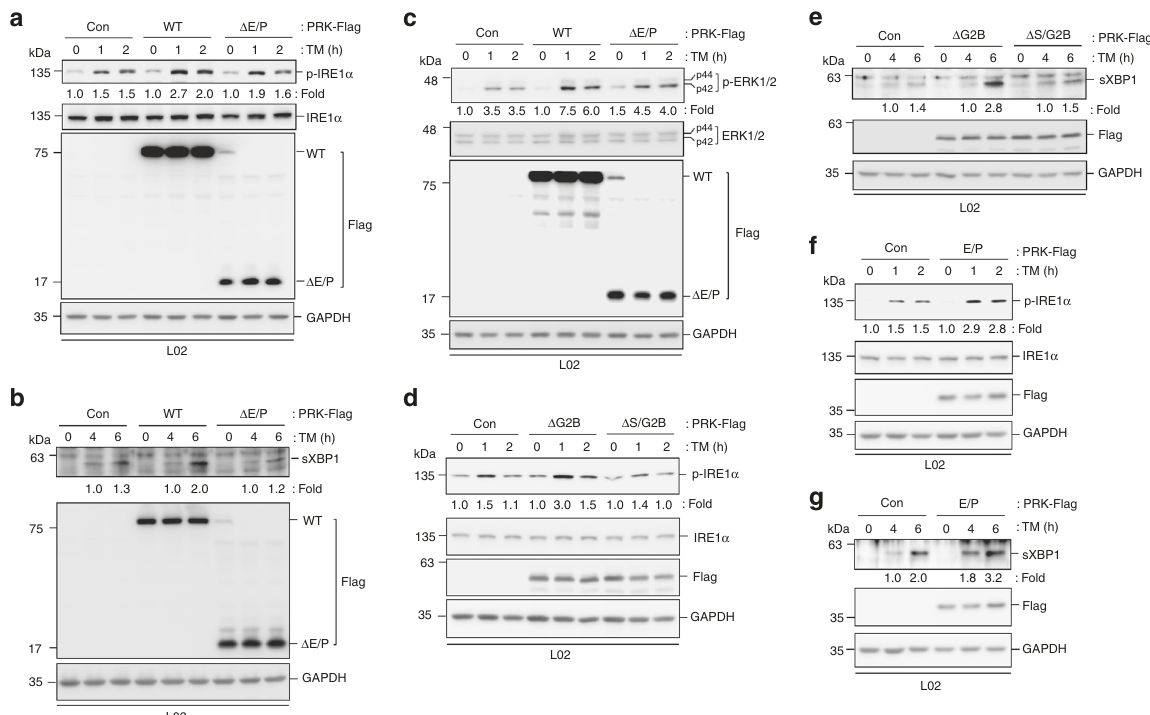
Fig. 6 Internal E/P domain of PRKCSH is required for boosting IRE1 α activation under ER stress. a – c Immunoblot analysis of IRE1 α phosphorylation ( a ), sXBP1 protein levels ( b ), and ERK phosphorylation ( c ) from L02 cells transfected with the control vector, WT PRKCSH, or its Δ E/P mutant; cells were treated with 10 μ g/mL TM for the indicated time. d , e Immunoblot analysis of IRE1 α phosphorylation ( d ) and sXBP1 protein levels ( e ) in L02 cells transfected with the control, Δ G2B, or Δ S/G2B mutant plasmids; cells were treated with 10 μ g/mL TM for the indicated time. f , g Immunoblot analysis of IRE1 α phosphorylation ( f ) and sXBP1 protein levels ( g ) in L02 cells transfected with the control, or E/P mutant plasmids; cells were treated with 10 μ g/mL TM for the indicated